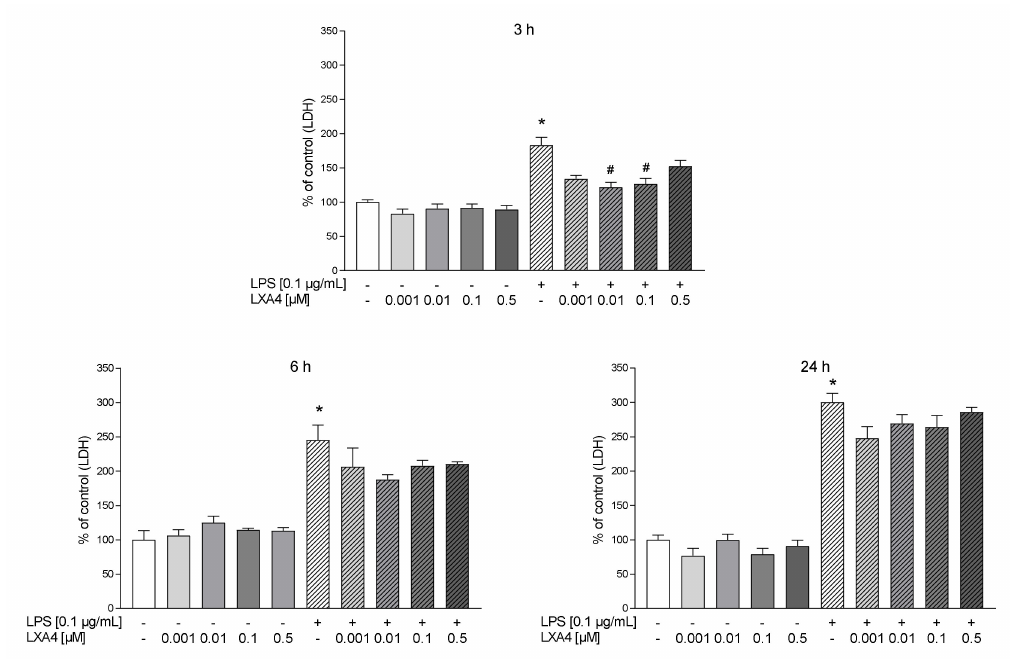
Figure 1. The impact of LXA4 on LPS-induced LDH release in rat microglial cultures. The cells were preincubated with LXA4 (0.001–0.5 µ M) for 1 h and then treated with 0.1 µ g/mL LPS for 3, 6, and 24 h. Control cultures were treated with the appropriate vehicle. The data are presented as the mean ± SEM percentage of control (vehicle-treated cells) of independent experiments, n = 2–5 in each experiment. * p < 0.05 vs. control group, # p < 0.05 vs. LPS group. LXA4–lipoxin A4; LPS–lipopolysaccharide; LDH–lactate